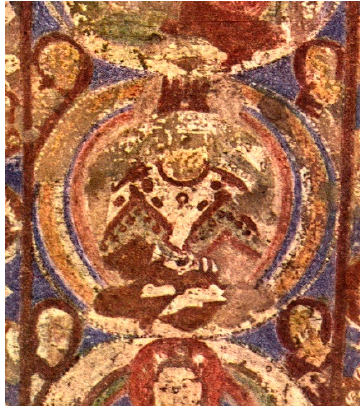
Figure 2. Buddha wearing a crown and cape. Painting in niche “I” at Bamiyan, seventh c. Photograph courtesy of John C. Huntington.